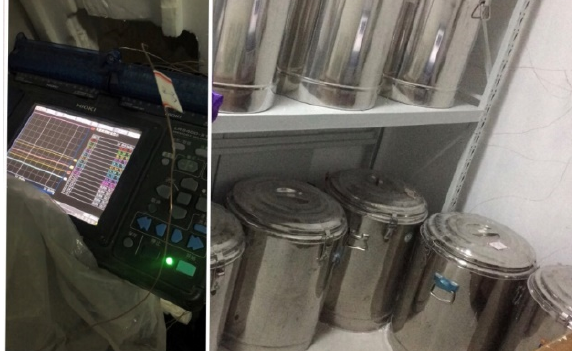
Figure 4. The semi-adiabatic calorimetry.